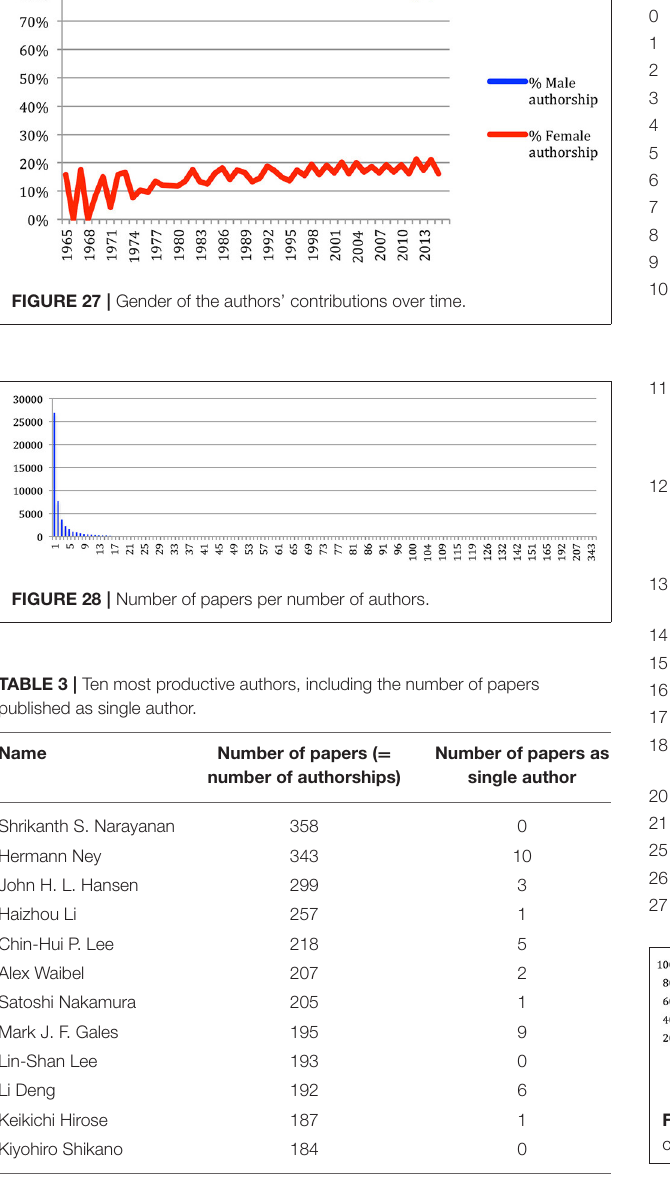
Collaboration Graph A collaboration graph 13 (CollG) is a model of a social network where the nodes (or vertices) represent participants of that network (usually individual people) and where two distinct participants are joined by an edge whenever there is a collaborative relationship between them. As opposed to a citation graph, a CollG is undirected. It contains no loop-edge (an author does not collaborate with himself/herself) and no multiple edges (there is a single edge between two authors, whatever the number of papers they published